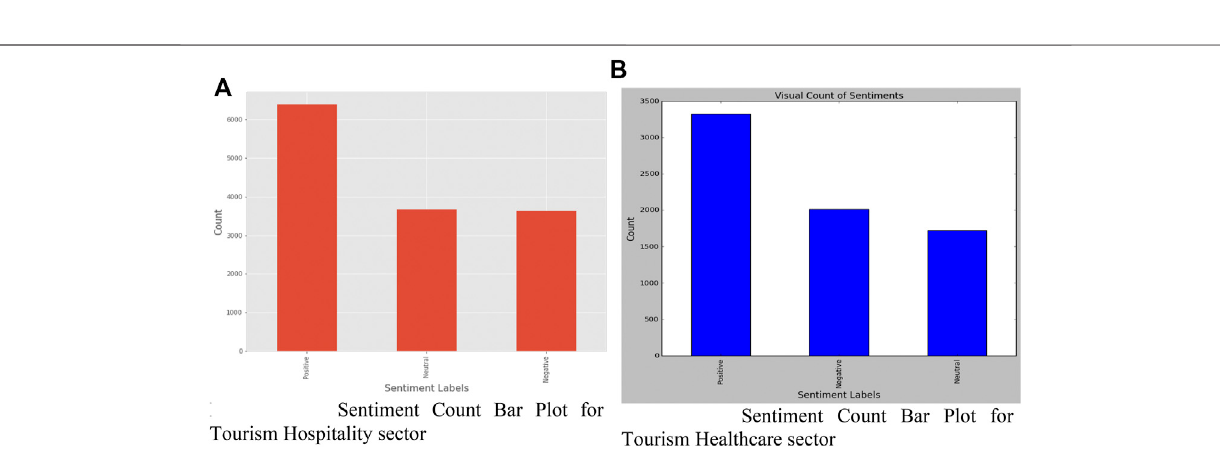
FIGURE 6 | (A) Sentiment Count Bar Plot for Tourism Hospitality sector (B) Sentiment Count Bar Plot for Tourism Healthcare sector.